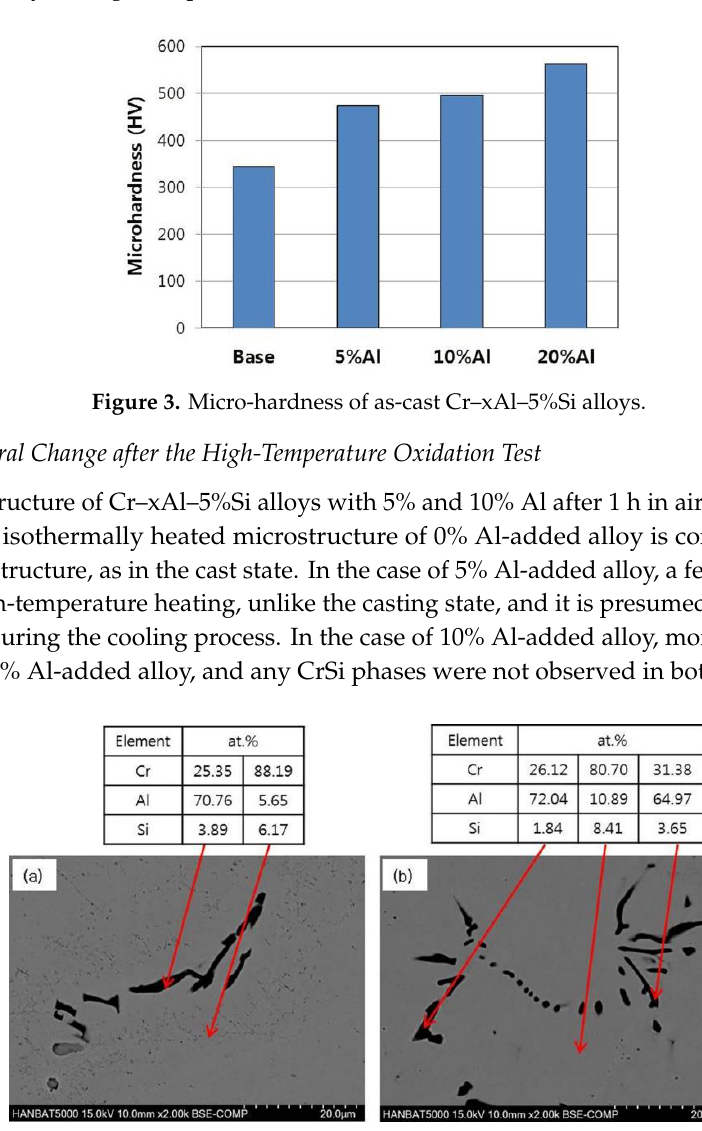
Figure 2. SEM-EDS analyses of as-cast Cr–xAl–5%Si alloys (2000X): ( a ) 10%Al; ( b ) 20%Al.